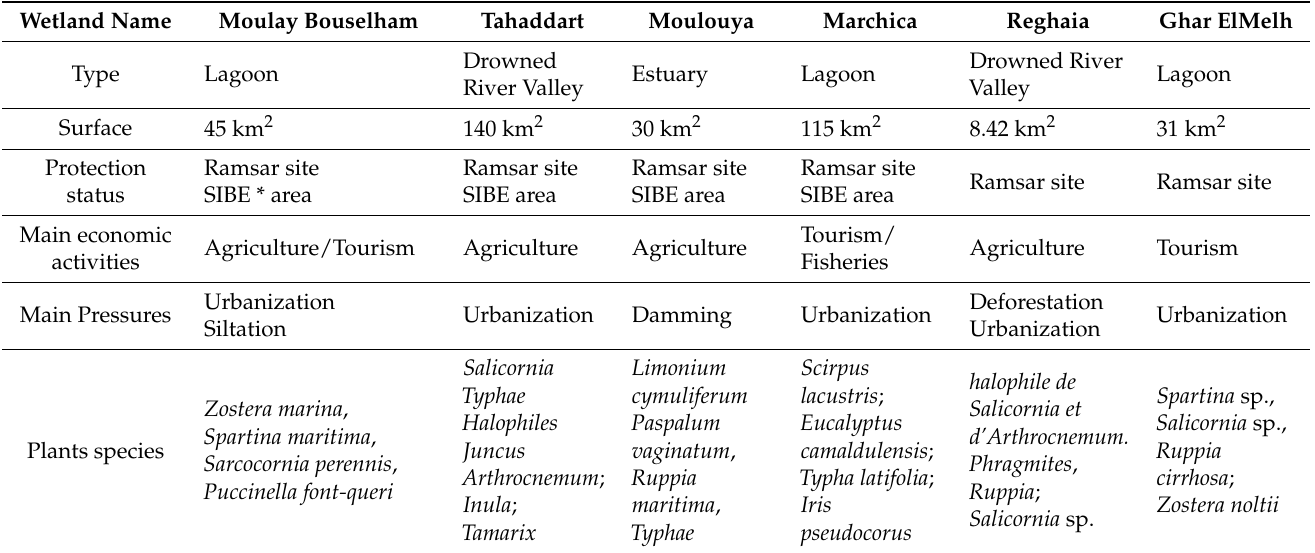
Table 1. Main characteristics of the study areas.